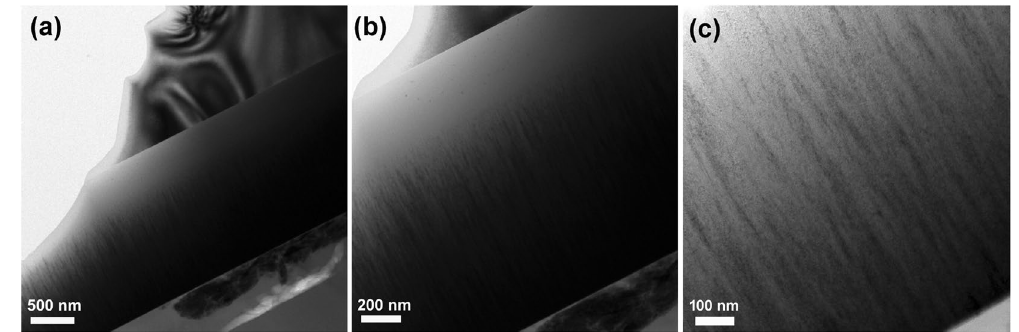
Figure 1. Cross-sectional TEM images of the TiSiCN film with the C/Si content ratio of 2:2. ( a ) low- magnification, ( b ) medium-magnification, and ( c ) high-magnification. The TiSiCN film exhibits elongated fibrous morphology, with the fiber width of about 20 nm–50